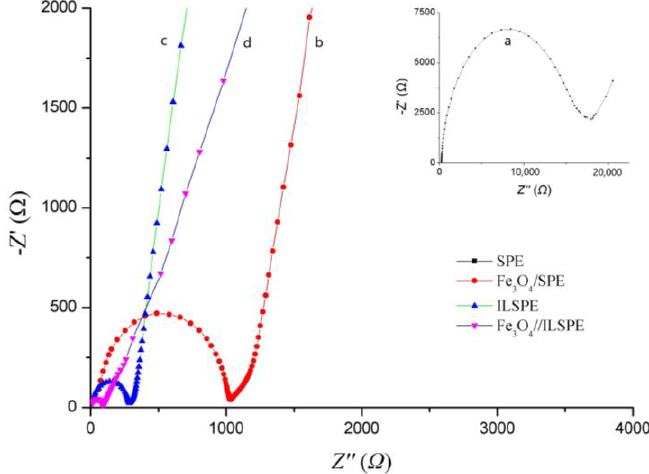
Figure 3. Electrochemical impedance spectra of different electrode in 5.0 mmol/L K 4 [Fe(CN) 6 ] + 0.1 mol/L KCl solution with the frequencies from 100,000 to 1 Hz, Ω ( a ) SPE, ( b )Fe 3 O 4 /SPE, ( c ) ILSPE, ( d ) Fe 3 O 4 /ILSPE.